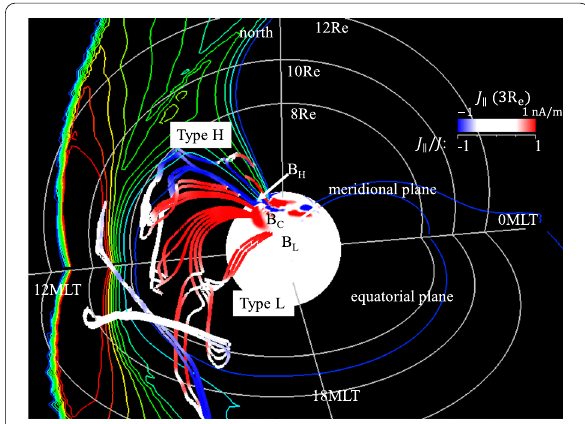
Fig. 4 Snapshots of the electric current systems at t the same format used in Fig. 3. B H , B C , and B L indicate the projection of the three areas in the ionosphere (Fig. 2) to the lower boundary. The currents from B H and B L are, respectively, the type H current system and the type L current system. The currents from B C belong to the type H current system or the type L current system. The type H current system advances the region of B C from t Note that the type L current system goes farther in the